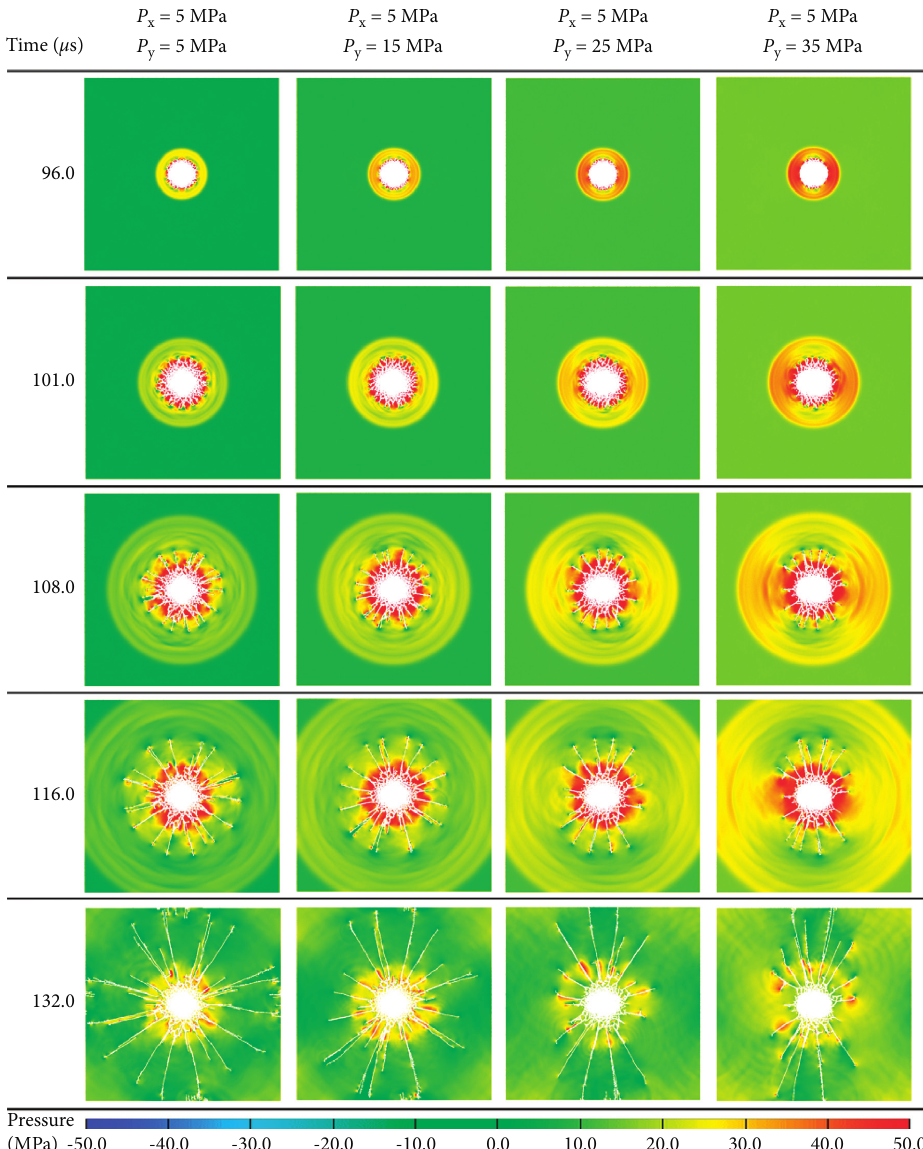
Figure 15: Pressure contours versus time under different P